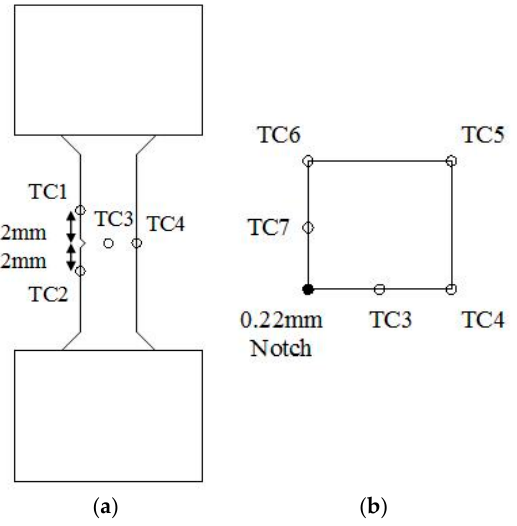
Figure 3. Thermocouple locations for thermal profiling ( a ) side view and ( b ) plan view.